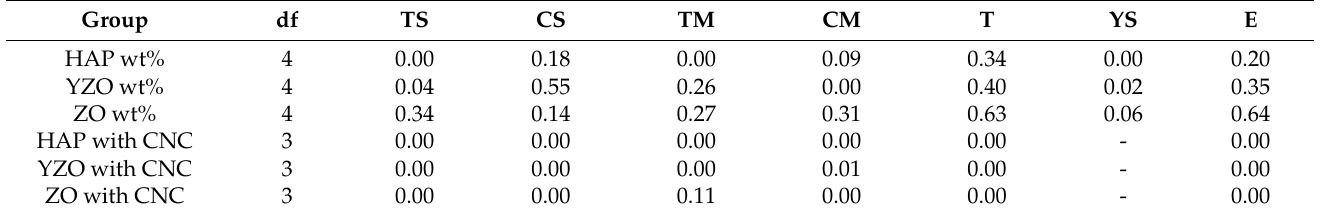
Table 4. ANOVA statistical analysis results ( p values) of the correlation between changes in mechani- cal properties as a function of composition of bioceramic–epoxy